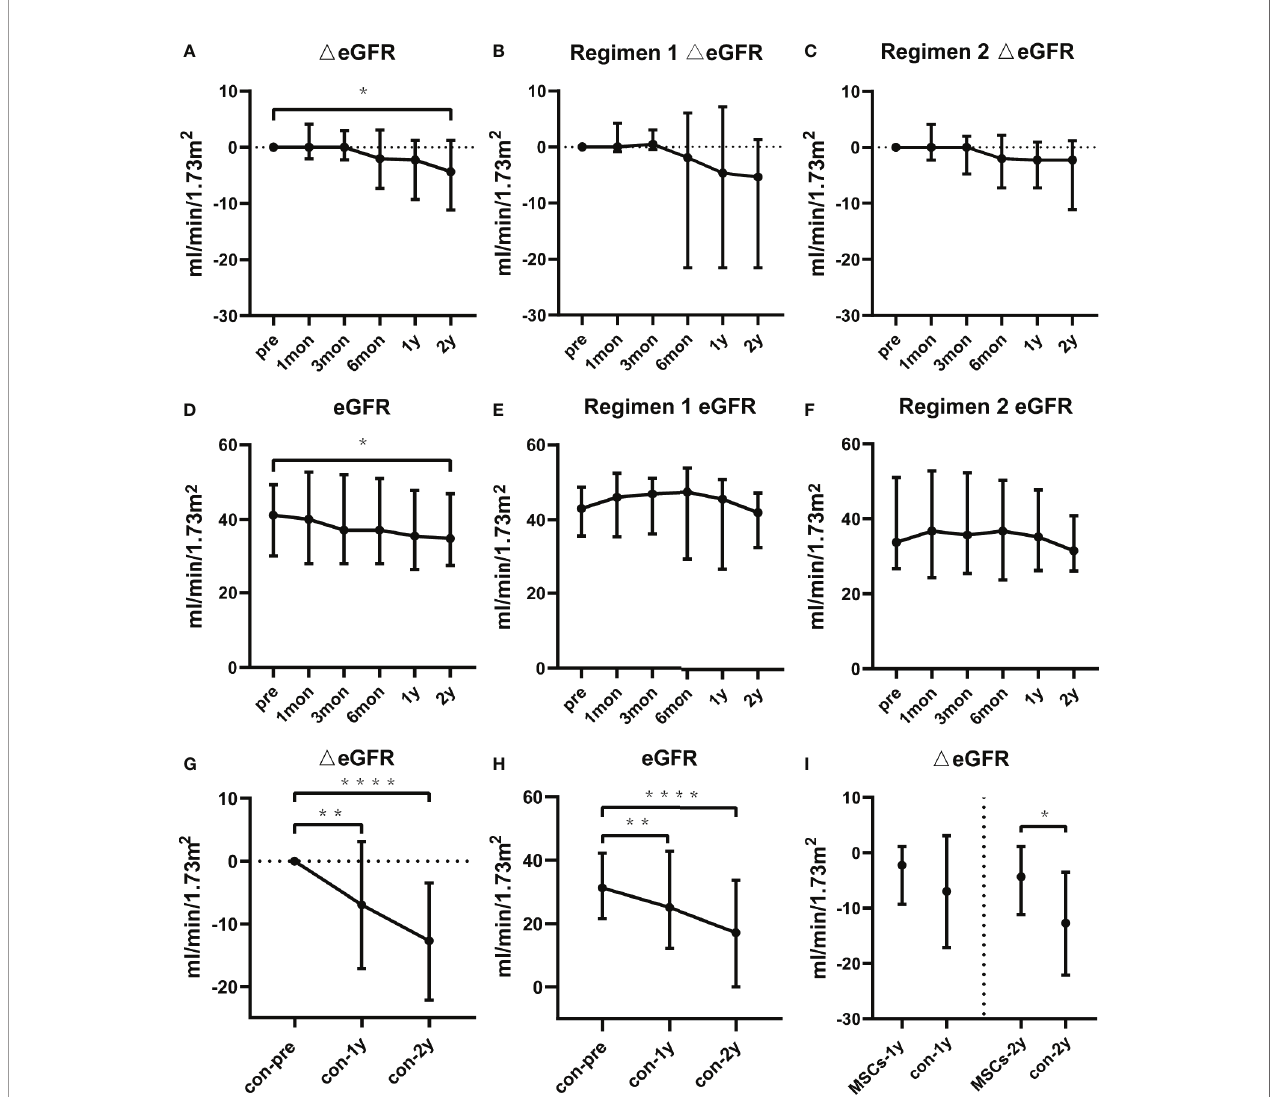
FIGURE 1 | Renal function of the BM-MSCs treated group and the contemporaneous control group in two years of follow-up. Delta estimated glomerular fi ltration rate (eGFR) pre and after BM-MSCs treatment in total BM-MSCs treated (A) , Regimen 1 (B) , and Regimen 2 populations (C) . eGFR pre and after BM-MSCs treatment in total BM-MSCs treated (D) , Regimen 1 (E) , and Regimen 2 populations (F) during the study period. Delta eGFR of the control group two years after histological diagnosis (G) . eGFR of the control group two years after histological diagnosis (H) . Comparison of delta eGFR between BM-MSCs treated group and the control group (I) . Points represent median. Bars represent the lower quartile and upper quartile. Data before and after BM-MSCs treatment or histological diagnosis were analyzed by Wilcoxon test. Data comparing BM-MSCs-treated and control groups were analyzed by Mann-Whitney test. *p < 0.05, **p < 0.01, ****p <